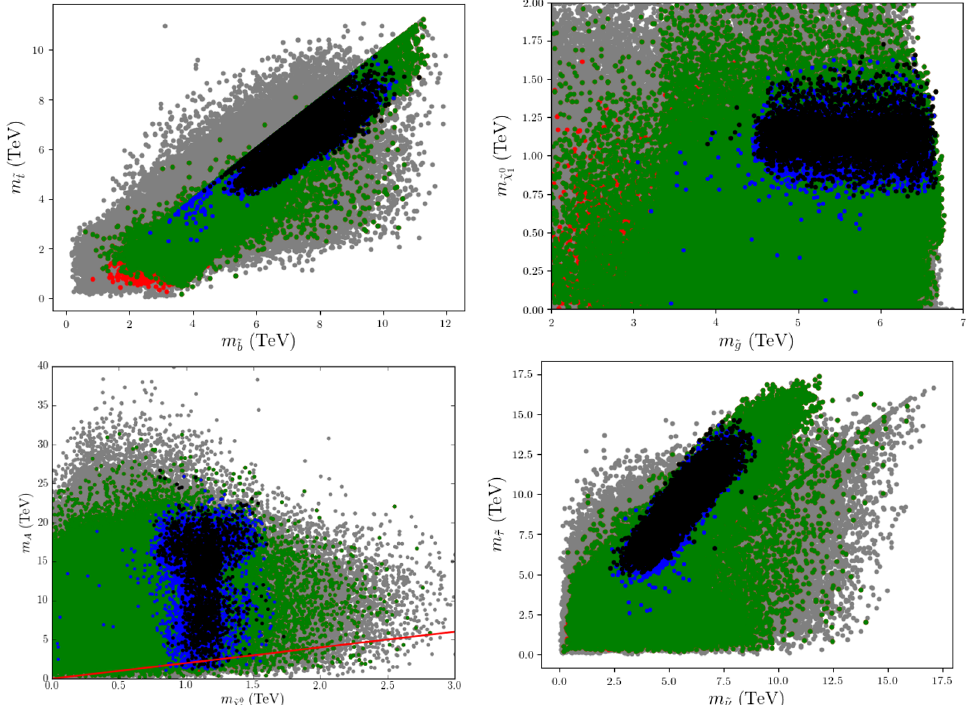
Figure 4 . The mass spectrum of Higgs and SUSY states over the following planes: ( m ~ left), ( m ~ g ; m ) (top right), ( m ; m A ) (bottom left) and ( m ~ (cid:23) ; m ~ (cid:28) ) (bottom right). Our colour ~ (cid:31) 0 1 ~ (cid:31) 0 1 convention is as listed at the end of section